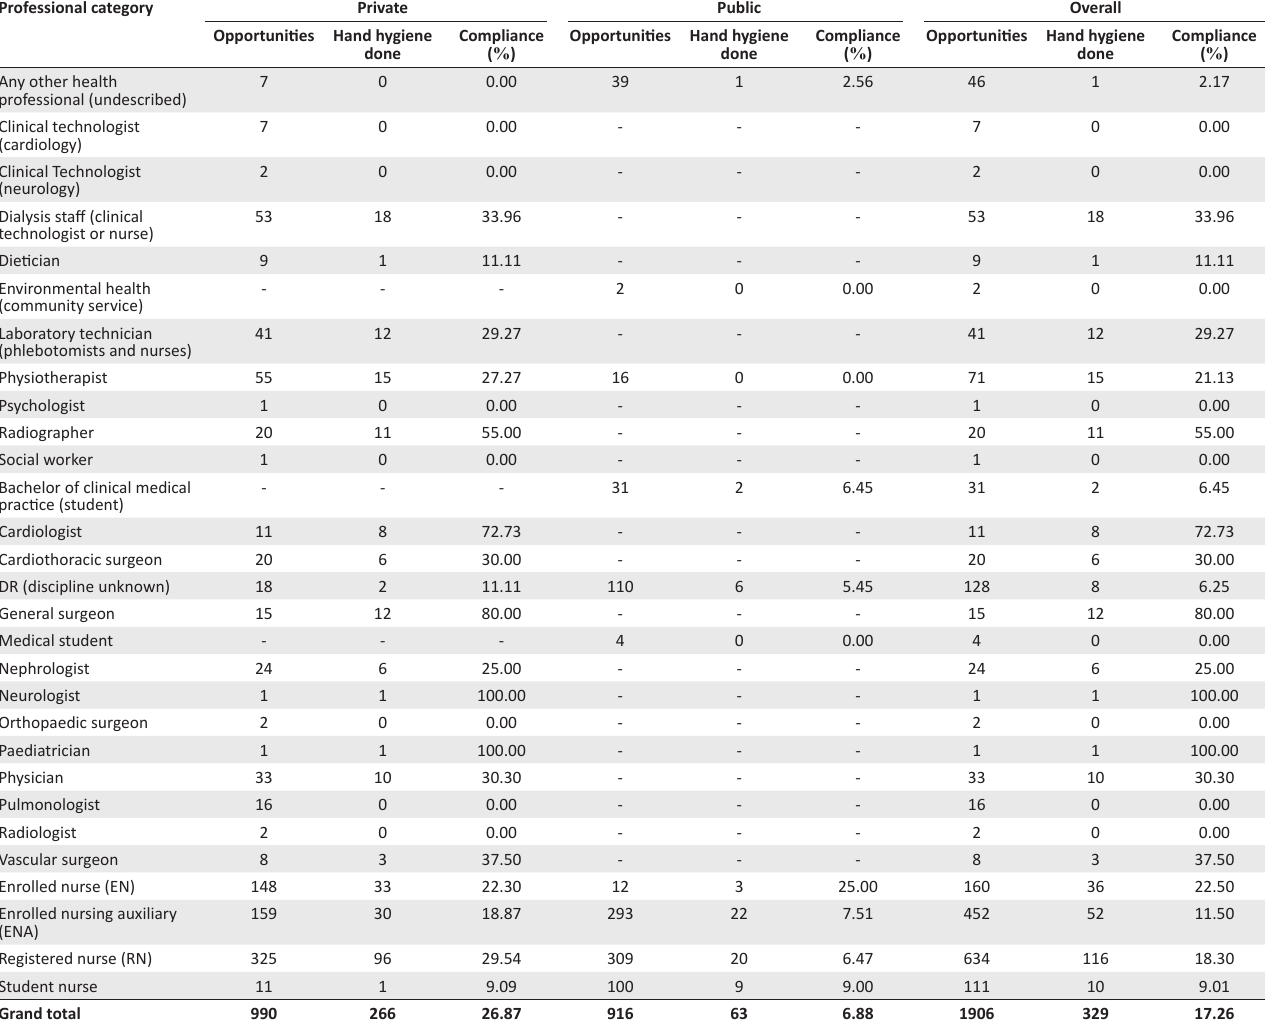
TABLE 2: Comparison of compliance to the five moments of hand hygiene in private versus public setting: Breakdown per professional code ( p = 0.010). Professional